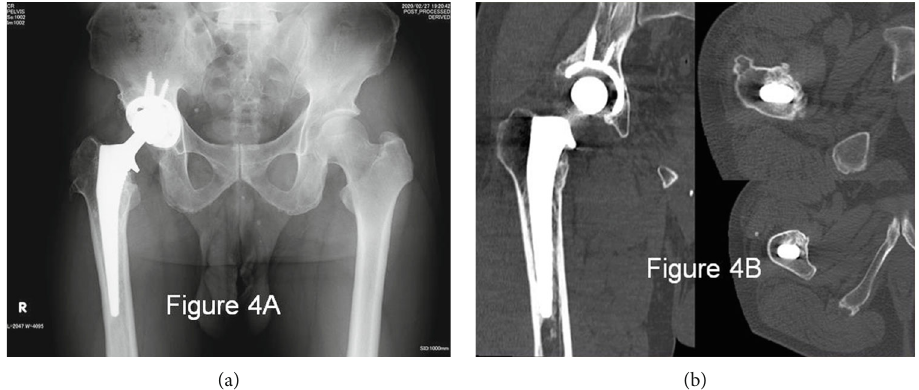
Figure 4: (a) 5 years and 3 months have passed and radiological images (Figure 4) showed that the calcar allograft united to the host bone with partial absorption and it showed no further subsidence compared to 1-year X-ray. (b) CT at 5 years and 6 months proves rigid fi xation in all Gruen zones except in zone 1.